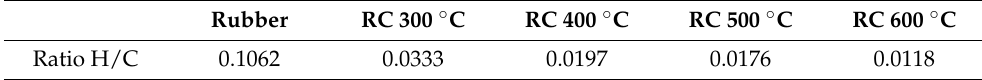
Table 5. Evolution of the H/C ratio with increasing